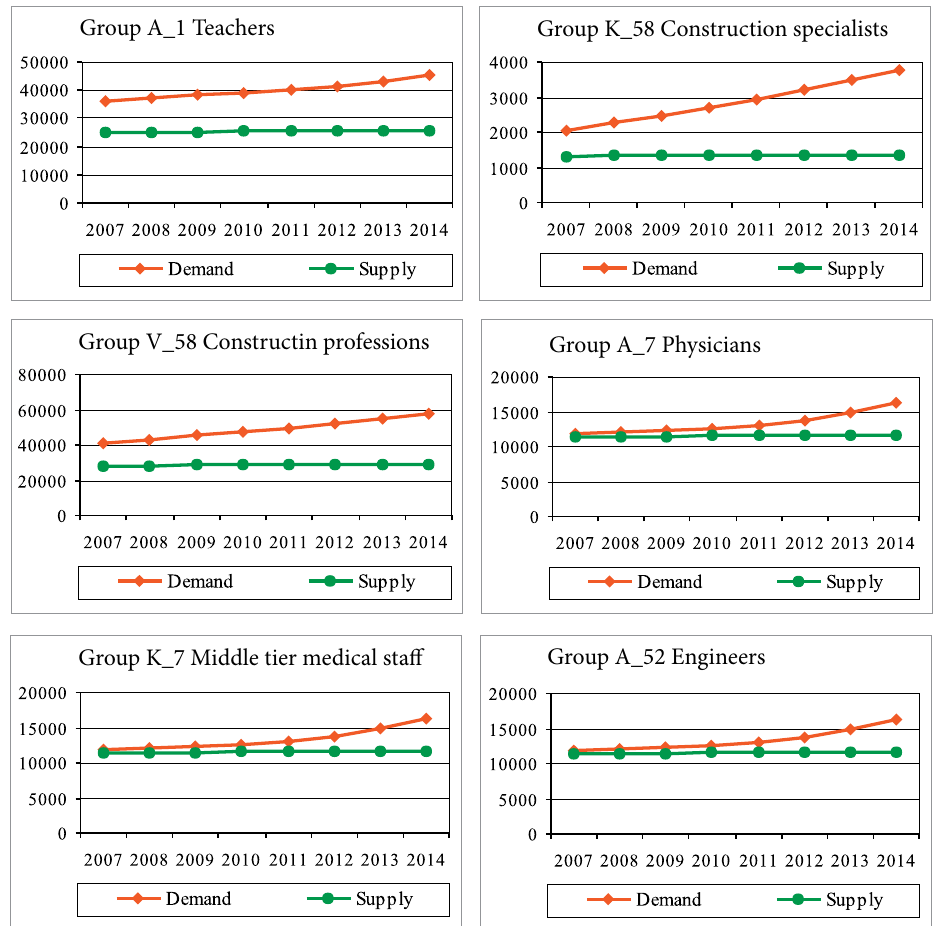
Fig. 4. Forecasts of the labour force demand and supply by a group of